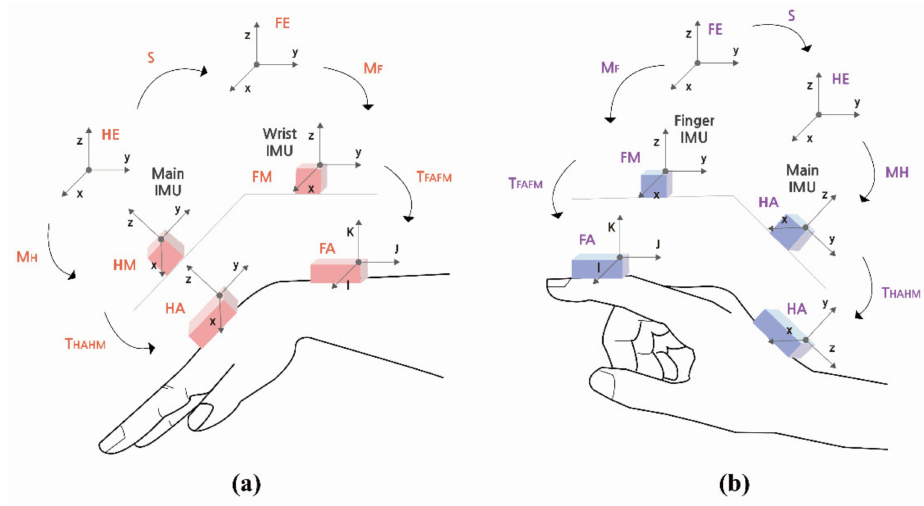
Figure 2. A coordinate system related to joint angle estimation: ( a ) hand to wrist; ( b ) finger to hand